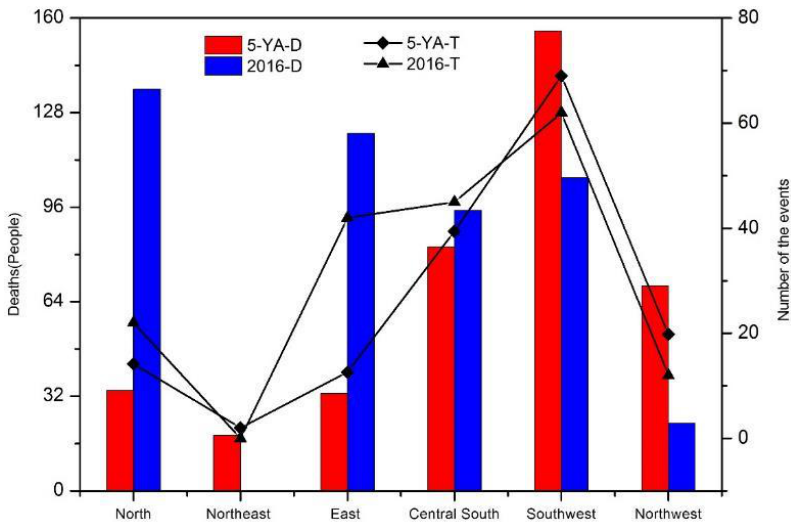
Figure 4. Regional distribution of flash floods in 2011 – 2016. (5-YA-D: the number of deaths from 2011 to 2015, 5-YA-T: the number of flash flood events from 2011 to 2015; 2016-D: the number of deaths in 2016, 2016-T: the number of flood events in 2016).